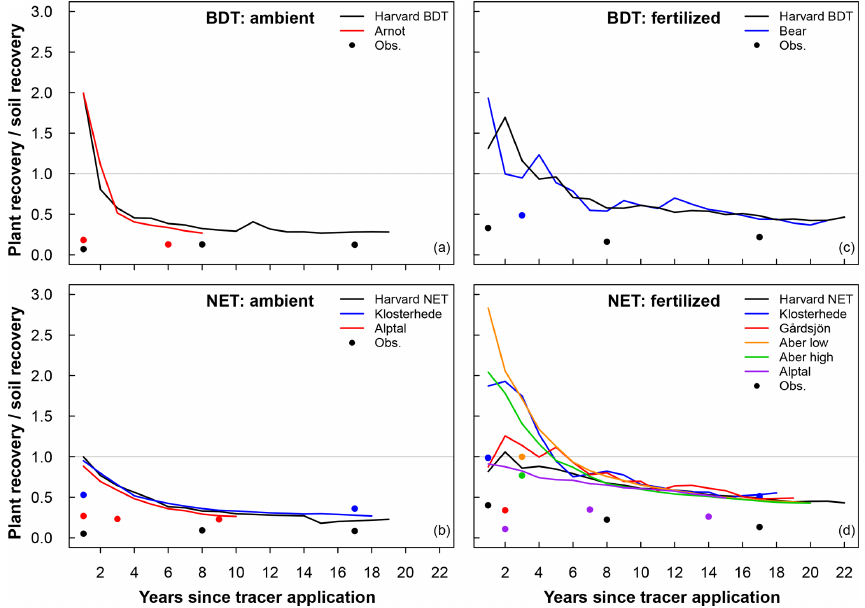
Figure 5. Ratio of plant recovery and soil recovery of added N into (a, c) broadleaf deciduous temperate (BDT) and (b, d) needleleaf evergreen temperate (NET) forests for sites with a closed N cycle under ambient deposition (a, b) and fertilized (c, d) conditions. Circles represent the ratio of plant to soil recovery of 15 N as measured in field experiments. A ratio of 1.0 represents equal recovery of N in plant and soil